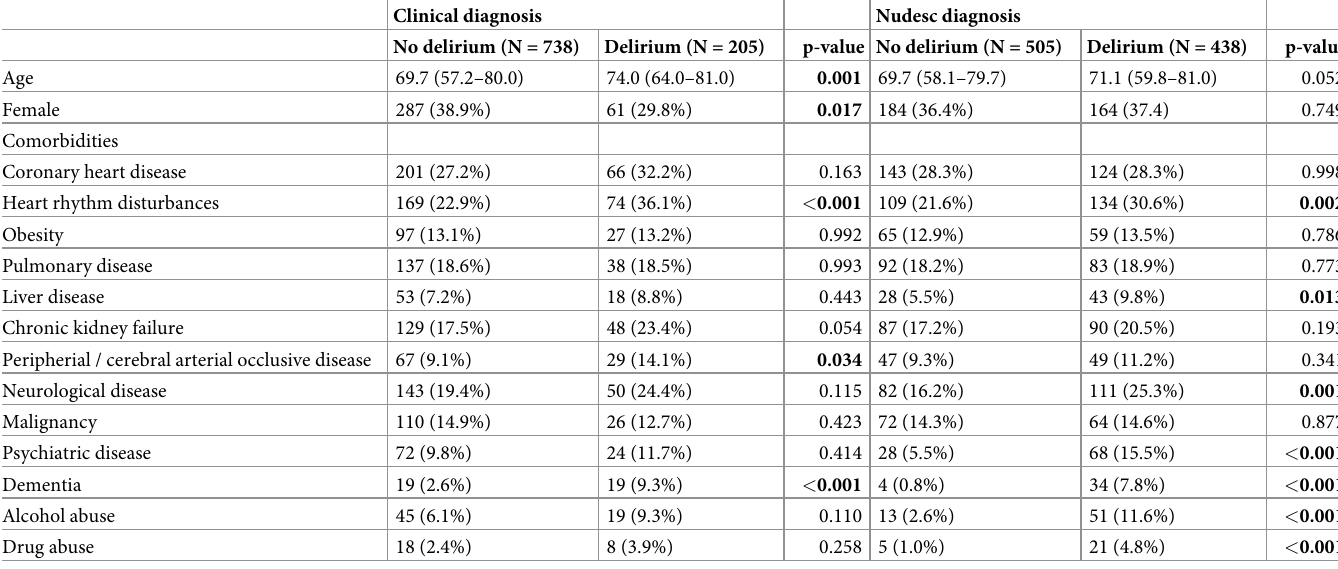
Fig 1. Flowchart indicating number of included and excluded patients. Data are given as number of patients. https://doi.org/10.1371/journal.pone.0259841.g001 Table 1. Baseline characteristics of all